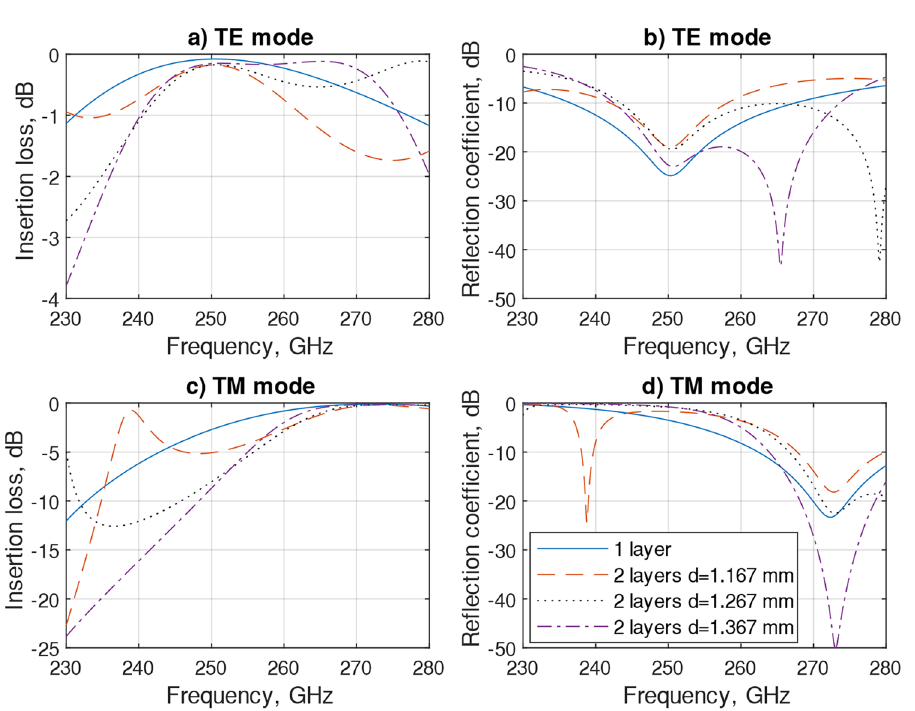
Figure 3. Simulated unit cell S-parameters: for TE polarization, ( a ) insertion losses and ( b ) reflection coefficient and for TM polarization, ( c ) insertion losses and ( d ) reflection coefficient. Filter was designed for 250 GHz TE